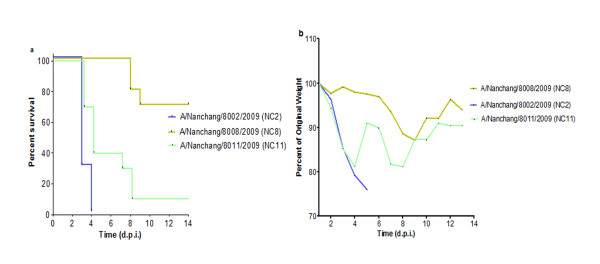
Comparison of the virulence of three pandemic H1N1 strains in C57/BL6 mice. Viral strains NC2, NC8 and NC11 were analyzed in C57/BL6 mice (n = 10/group). Viral infection was established with 105 EID50 of NC2, NC11 and 106 EID50 of NC8 and animals were observed up to 14 days. (a) Kaplan Meier’s analysis shows overall difference in survival curves (P 0.0007). Log-rank sum test shows differences between mortality curves: NC2 vs NC8 (P < 0.0001), NC2 vs NC11 (P 0.0195) and NC8 vs NC11 (P 0.0007). (b) Weight loss curve for the group of animals infected with NC2, NC8 and NC11. Significant differences were observed at 3 d.p.i., NC8 vs NC2 (P < 0.0001), NC8 vs NC11 (0.0007).